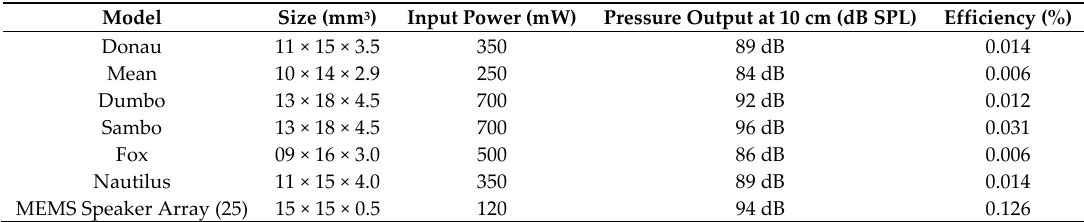
Table 1. Comparison of size and efficiency between various dynamic speakers from Knowles, USA and our biomimetic MEMS speaker